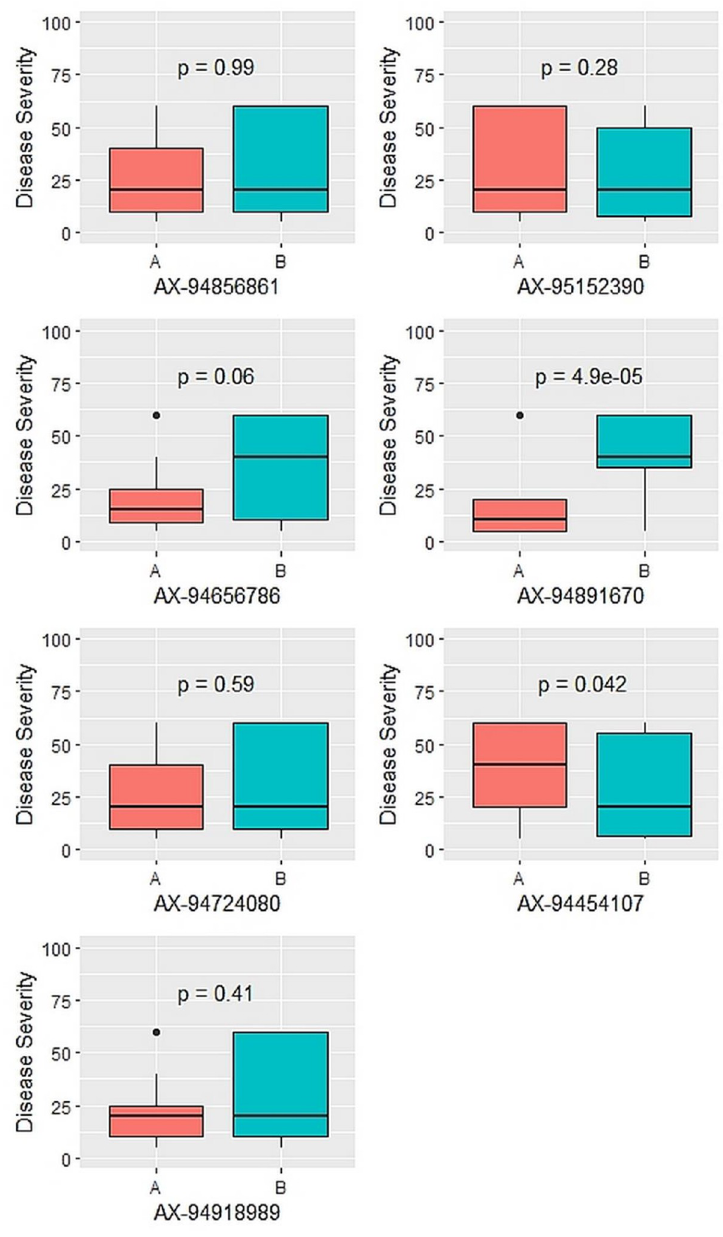
Fig 3. Boxplots showing the effect of phenotypic variation between the two alleles of the SNP markers linked to QTLs for disease score of stripe rust. Kruskal-Wallis test was used to determine the significant differences between the mean values of two